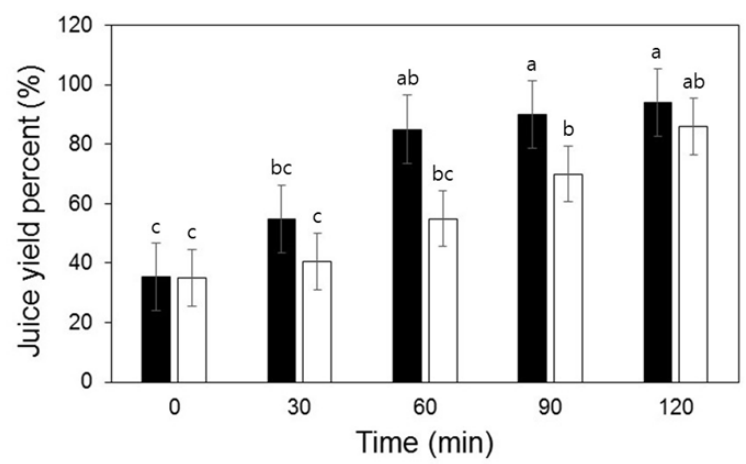
Figure 1. Effect of incubation time on mango juice yield following the treatments with the combination of ultrasonication and pectinase (T5) and pectinase alone (T4). , Combination of ultrasonication and pectinase treatment (T5); , Pectinase alone treatment (T4). Values are presented as means, and error bars represent SD. Letters a–c denote statistical significance at p < 0.05.